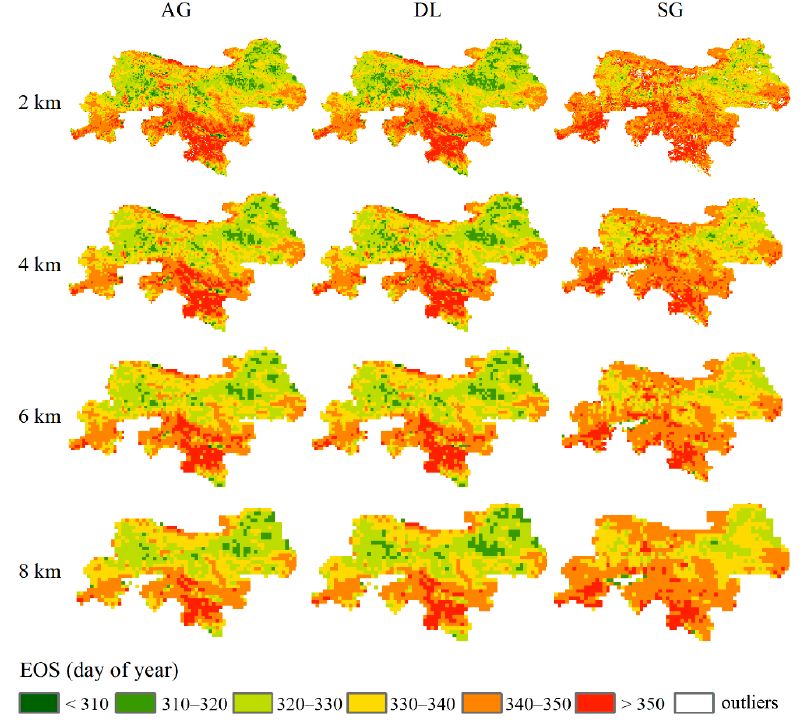
Figure A3. Up-scaled EOSs from 250 m EOSs. (SG, Savitzky-Golay; AG, asymmetric Gaussian; DL, double logistic.)